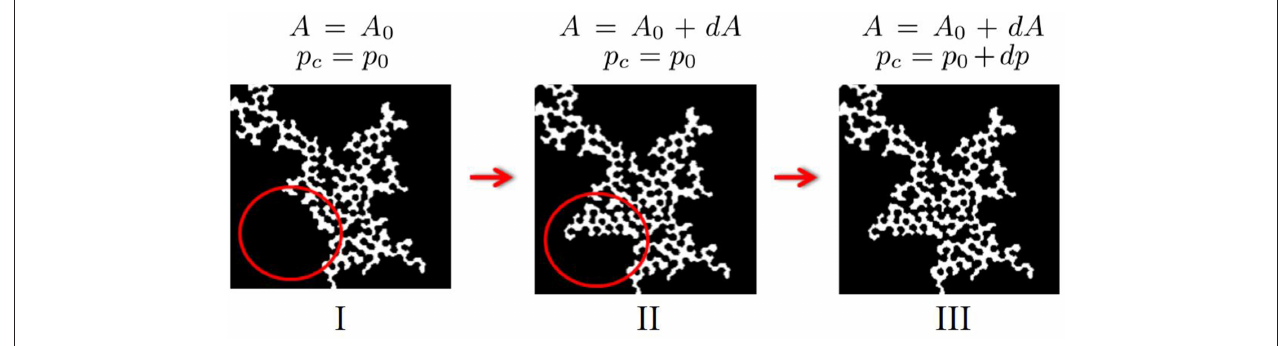
FIGURE 2 | Feedback loop used to drive the CIP experiments. This figure shows a detail from the black and white thresholded image, where the air phase is white and the liquid phase together with the porous medium are black. From I to II, the area of the air phase has grown from A 0 to A 0 constant at p 0 (no change in the liquid reservoir position). From II to III, the area of the air phase does not change, which means the capillary pressure must be dp (by lowering the liquid reservoir and thus decreasing the pressure in the liquid phase). This analysis is done “on the fly” as the experiment increased from p 0 to p 0 + is performed. Adapted from Moura et al. [74] under the Creative Commons CCBY